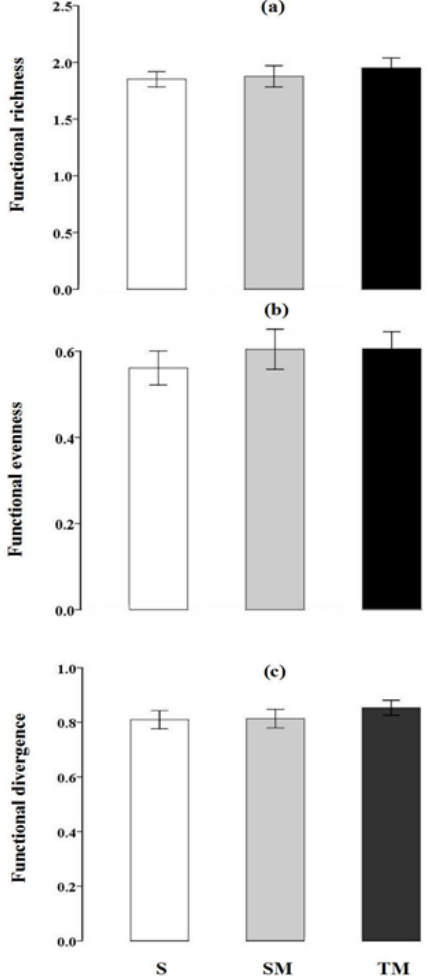
Figure 2. The changes in CWM trait across three habitats. CWM is community-weighted mean trait values, SLA is leaf area per unit dry mass, LDMC is leaf dry matter content, LA is leaf area, MPH is mature plant height, S is swamp, SM is swamp meadow, and TM is typical meadow. Significant differences indicated by dissimilar letters above each bar were determined using Tukey’s honest sig- nificant difference (HSD) test ( P <0.05) after one-way ANOVA.